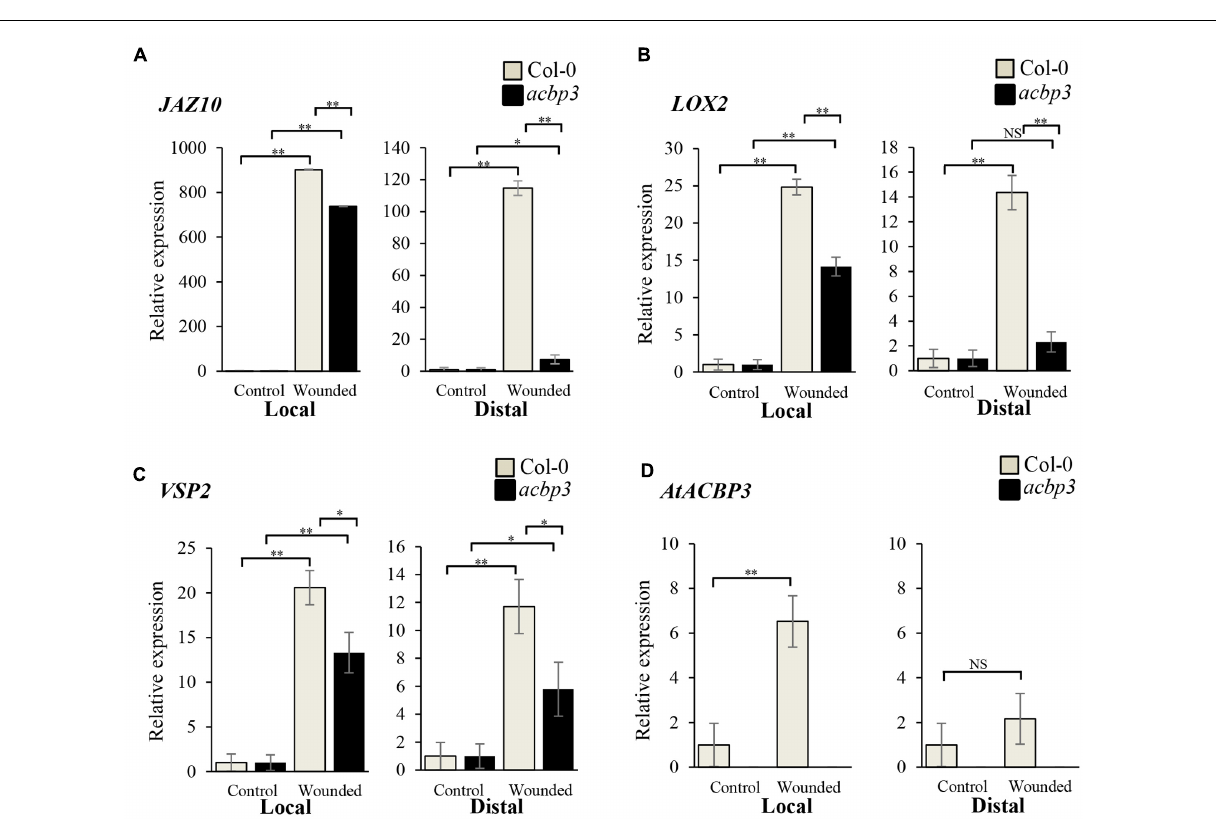
FIGURE 4 | Relative expression of AtACBP3 and marker genes in the Arabidopsis jasmonate pathway after wounding. Rosette leaves harvested from 5-week-old Col-0 and acbp3 were leaf 8 (wounded locally) and leaf 13 (distally wounded at leaf 8). Numbering of rosette leaves was according to Farmer et al. (2013). (A) Relative expression of JAZ10 1 h post wounding (hpw) following Mousavi et al. (2013). (B) Relative expression of LOX2 (2 hpw) following Glauser et al. (2009). (C) Relative expression of VSP2 (4 hpw) following Mousavi et al. (2013). (D) Relative expression of AtACBP3 1 hpw. Error bars represent standard deviation in each analysis. Square brackets indicate which two groups were compared using the Student’s t- test. ∗∗ P < 0.01, n = 3; ∗ P < 0.05, n = 3; NS, not significant, n = 3; Local, wounded leaf 8; Distal, leaf 13 distal to wounded leaf 8. These experiments were repeated twice with consistent